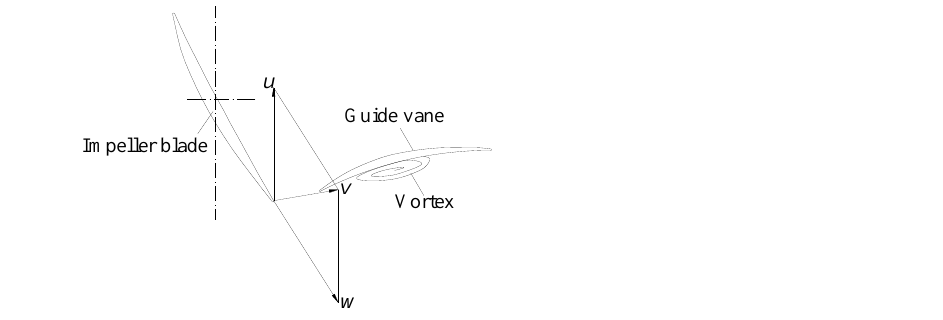
Figure 12. Velocity triangle of impeller blade outlet under large discharge condition.